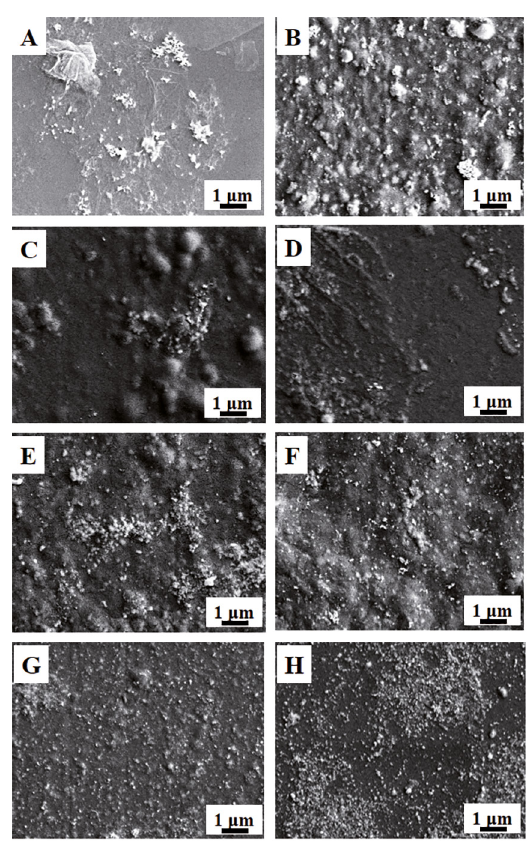
Figure 3: SEM images of (A) RGO-Ag, (B) CA-Ag, (C) CA-RGO- Ag-1, (D) CA-RGO-Ag-2, (E) CA-RGO-Ag-3, (F) CA-RGO-Ag-4, (G) CA-RGO-Ag-5 and (H)